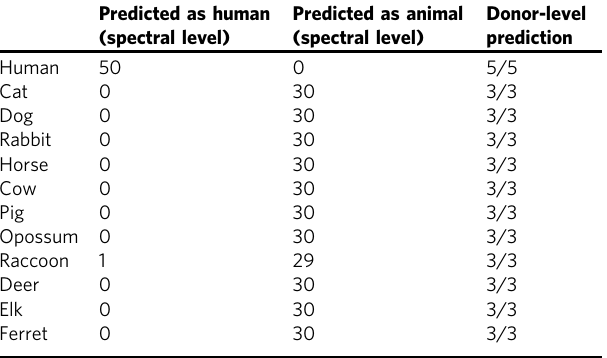
The table shows results at the spectral level and the donor level (when more than 50% of spectra from one donor are correctly classi fi ed).